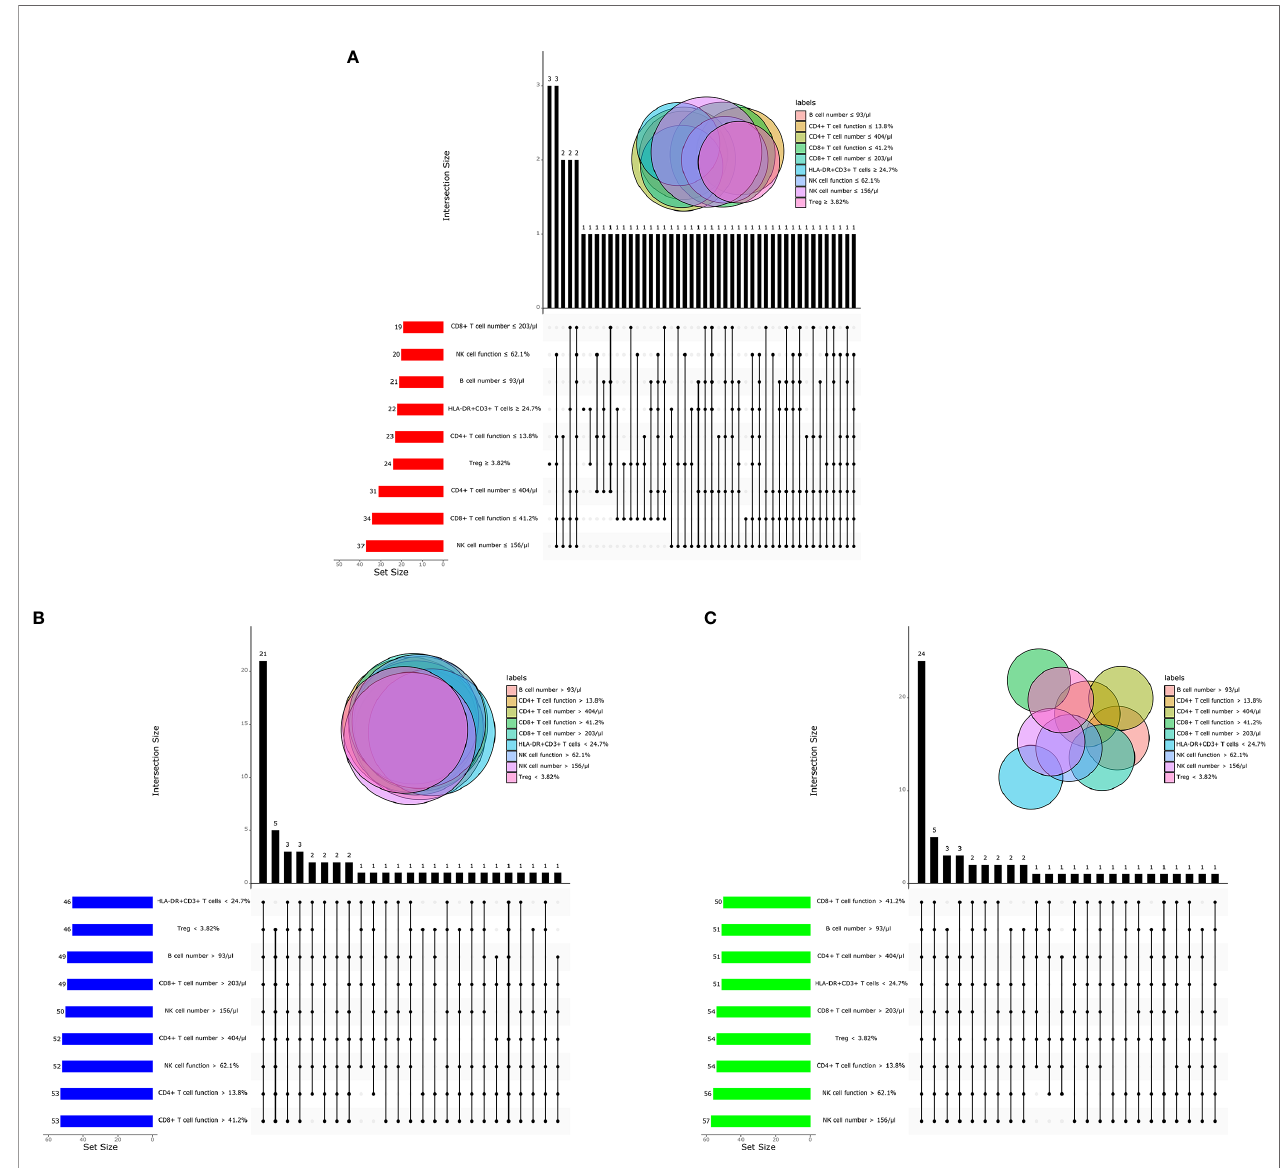
FIGURE 5 | The cross set between various immune indicators in ATB, LTBI, and HC. (A) Upset plot showing the cross set between various immune indicators in ATB. (B) Upset plot showing the cross set between various immune indicators in LTBI. (C) Upset plot showing the cross set between various immune indicators in HC. ATB, active tuberculosis; LTBI, latent tuberculosis infection; HC, healthy